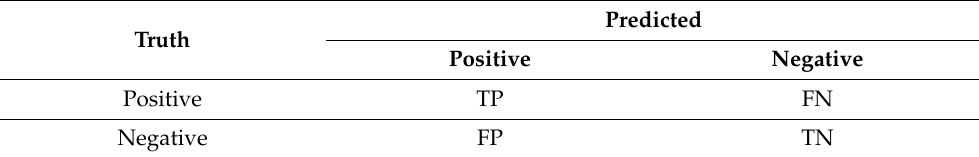
Table 2. Confusion matrix for classification results.